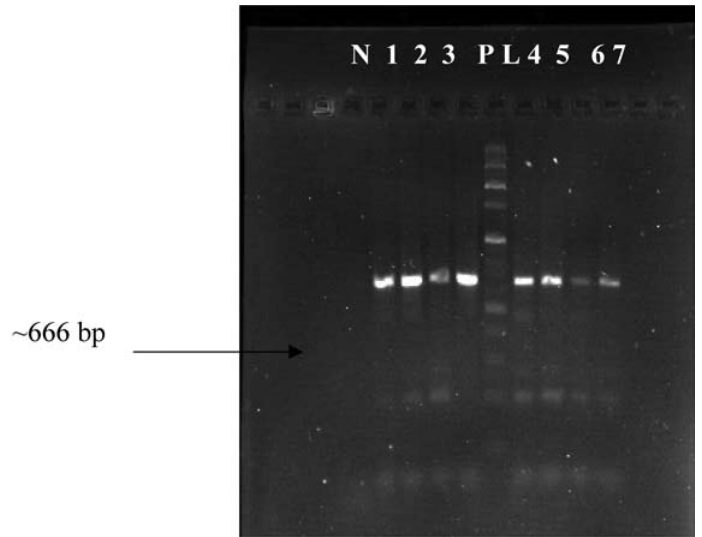
Fig. 1. Polymerase Chain Reaction amplification of 18S rRNA sequence of the Hepatozoon spp. from seven cats N: Negative control, P: Positive control, L: 100bp Ladder, 1-7: Samples Conflict of